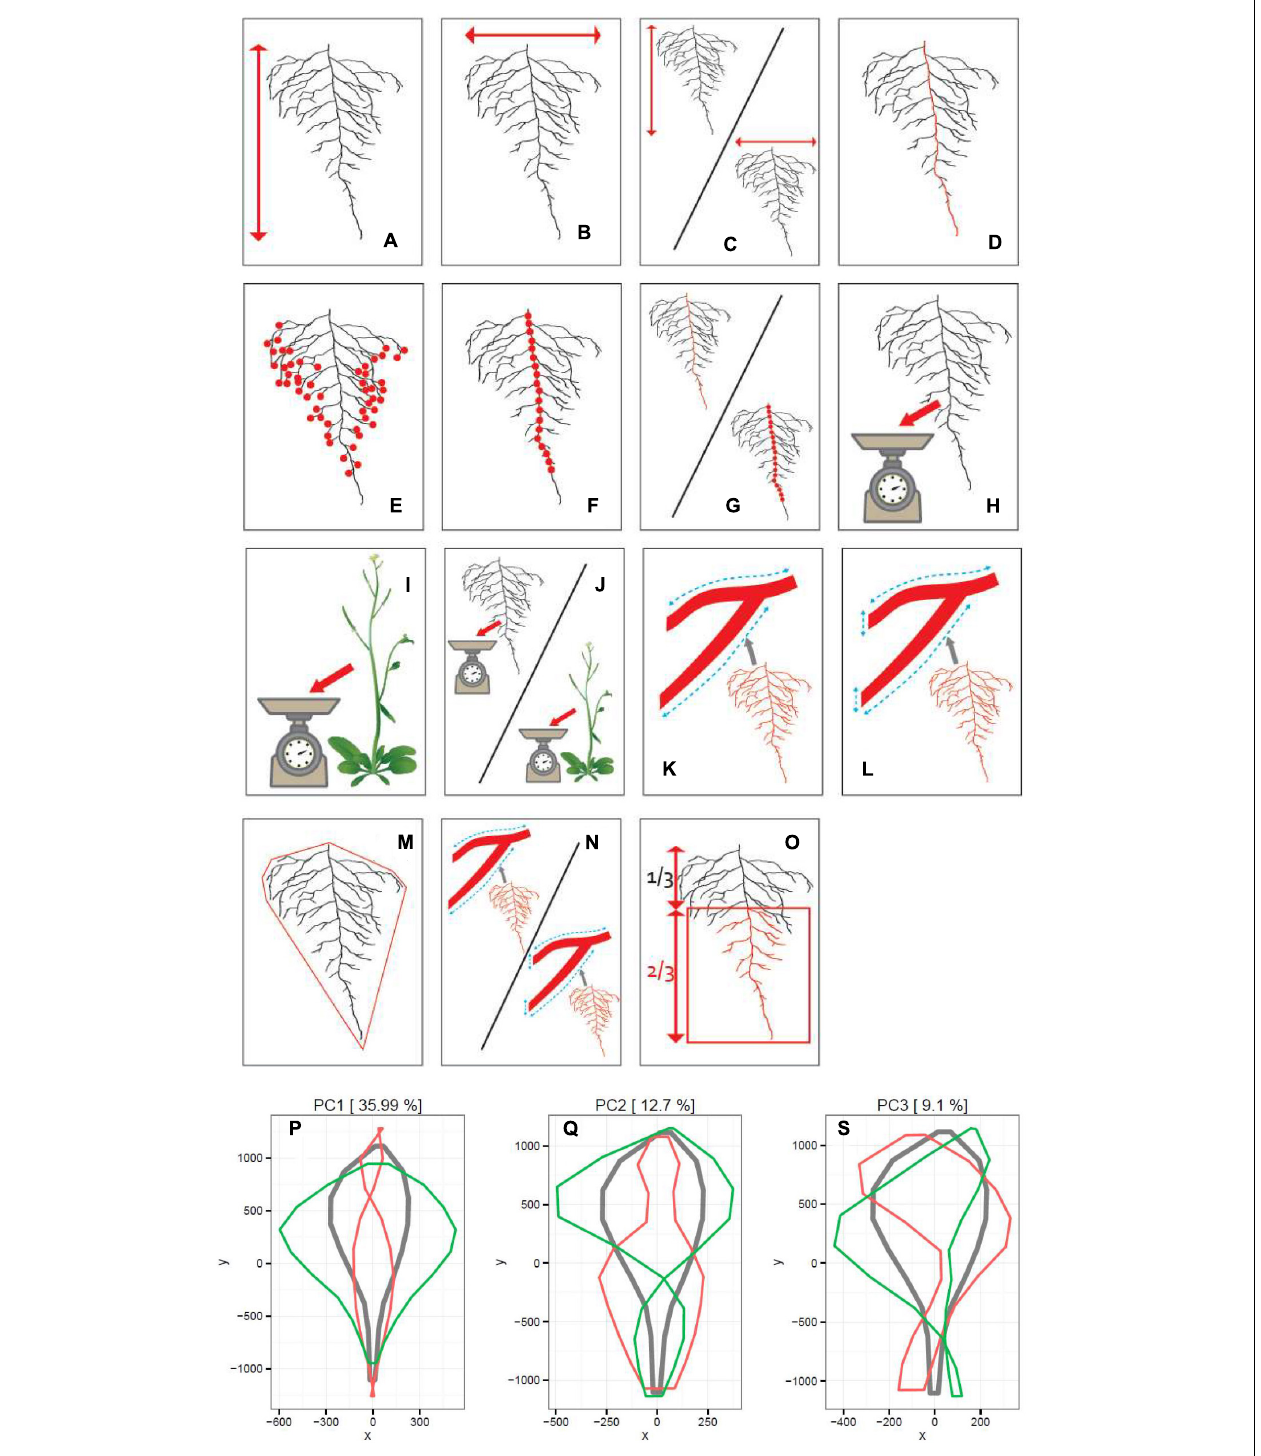
FIGURE 1 | Schematic representation of 15 RSA and 3 PC traits measured on 241 accessions. Panels from (A–O) correspond to 15 traits listed in Table 1 . In Panels (P,R,S) , the results of the PCA are shown. The red line represents the maximum and the green line the minimum values observed. The gray line represents the average of all values for 241